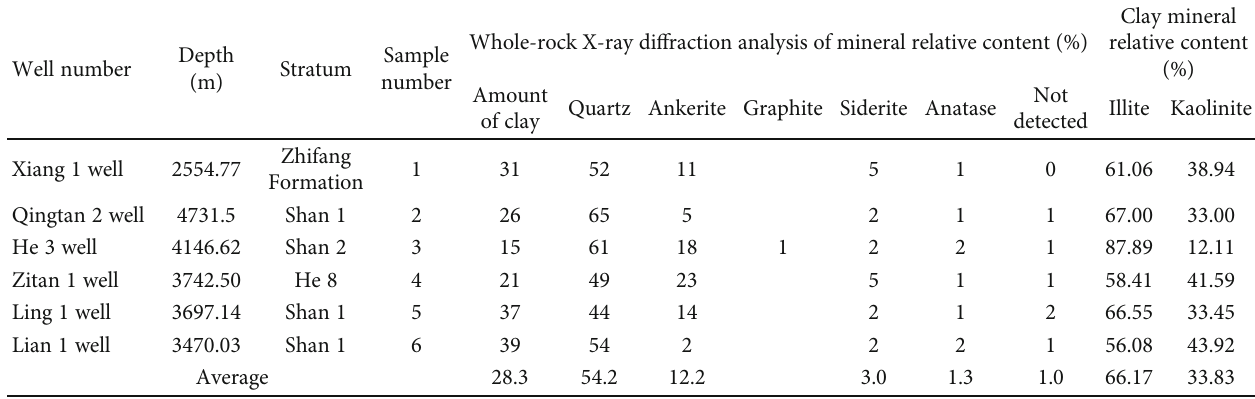
Table 1: Whole-rock X-ray di ff raction analysis of sandstone and clay in the Upper Paleozoic of the study area.